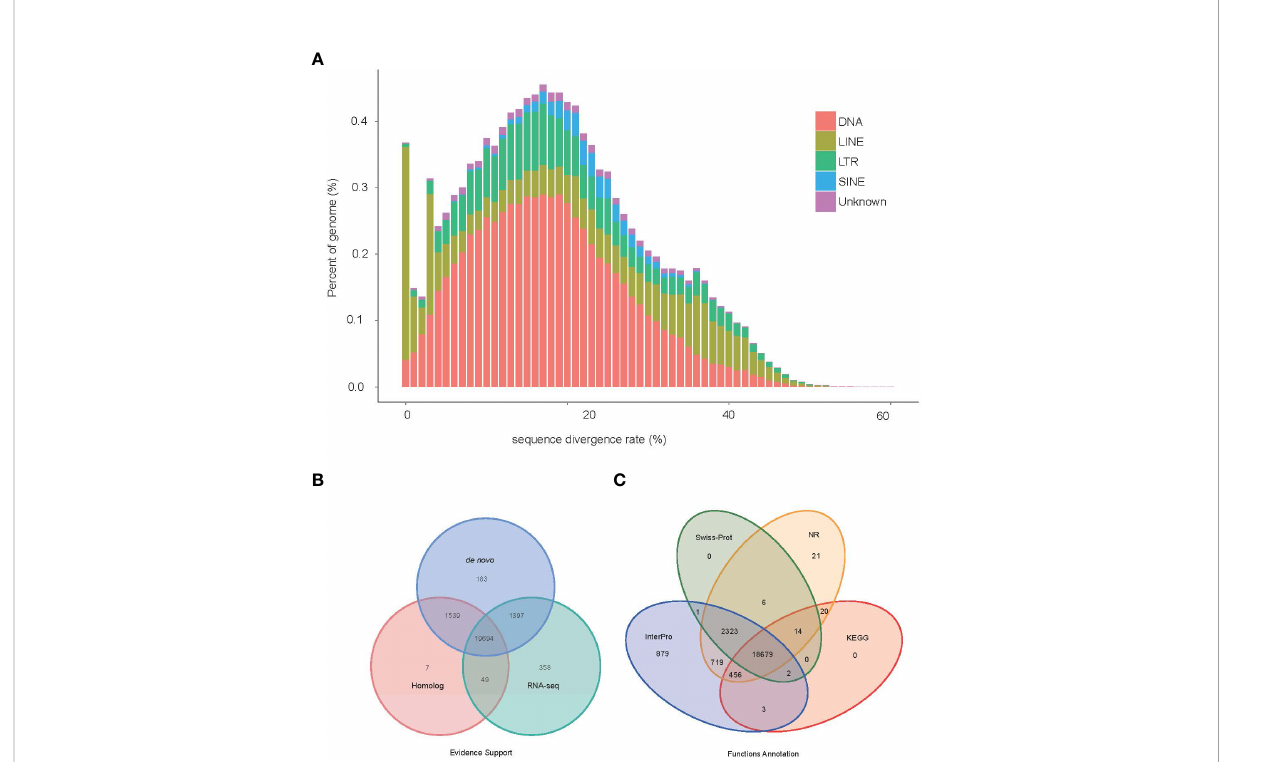
FIGURE 3 Genome annotation information (A) TE divergence distribution, the x-axis is the degree of divergence between the annotated TE sequence in the genome and the corresponding sequence in Repbase. The y-axis is the percentage of TE sequence in the genome. (B) Statistics supported by evidence for protein-coding gene sets. (C) Statistical results of gene function annotation.